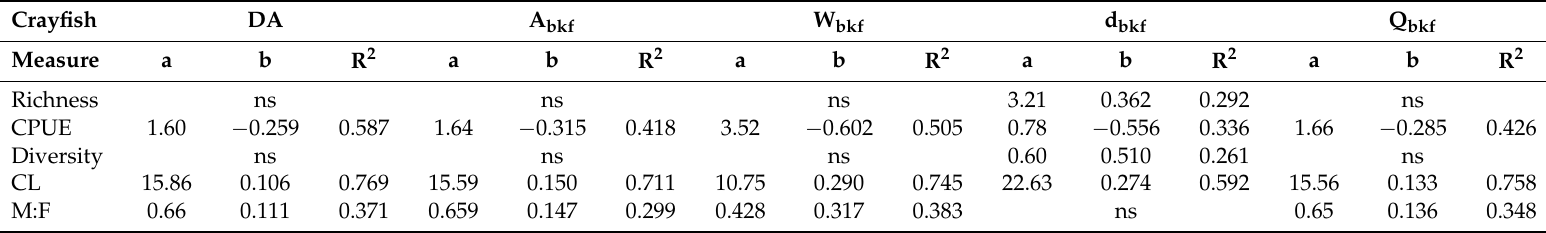
Table 8. Significant ( p < 0.05) relationships between measures of crayfishes and bankfull dimensions for Alabama Piedmont reference streams. Values are the parameters (a and b) and coefficient of determination (R 2 ) for the power model y = ax b , where y is the crayfish measure and x is the bankfull dimension measure. See text for definitions of crayfish and geomorphic variables.